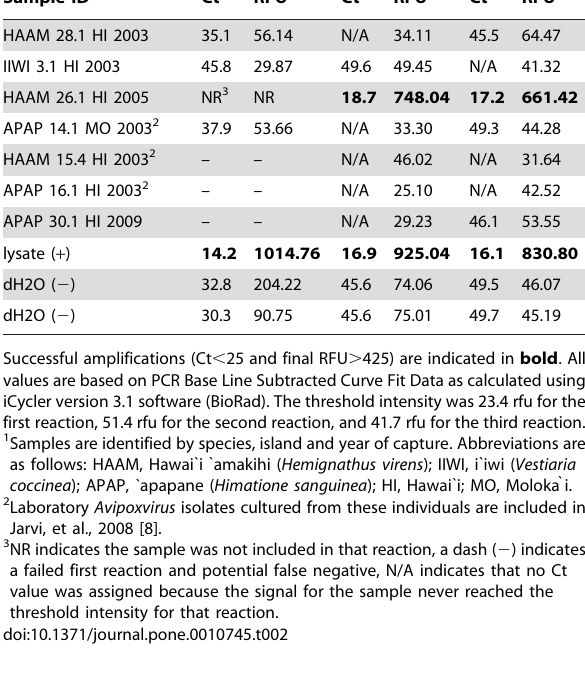
Table 2. Ct values and final intensities from triplicate nested TaqMan Real-Time PCR reactions for packed cell samples from wild honeycreepers with confirmed Avipoxvirus infections.